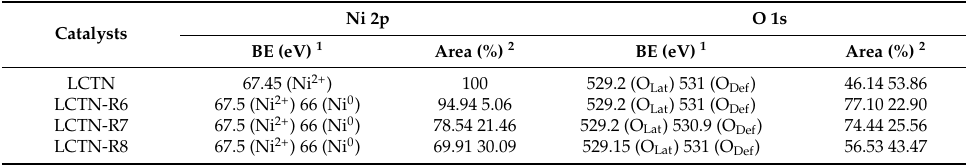
Table 2. Binding energies and peak areas for Ni 2p and O 1s XPS spectra.